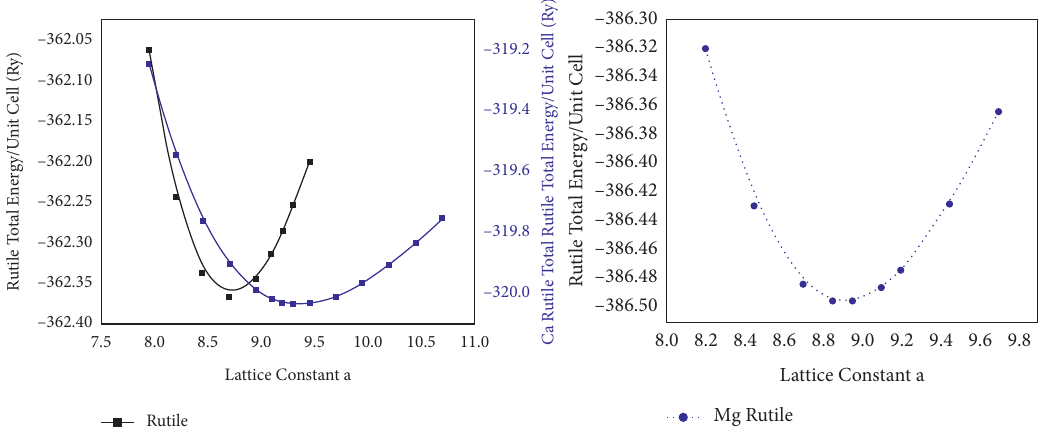
Figure 5: Total energy vs. lattice constants of pure and doped rutile.